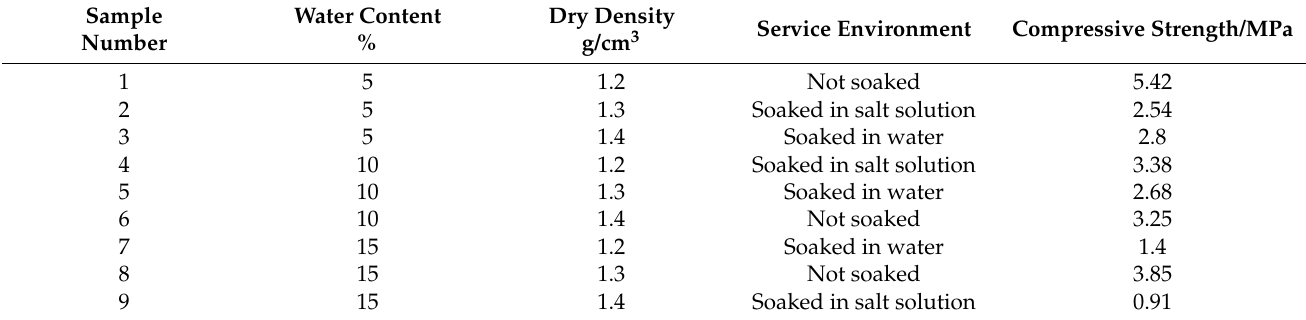
Table 7. Orthogonal test design.